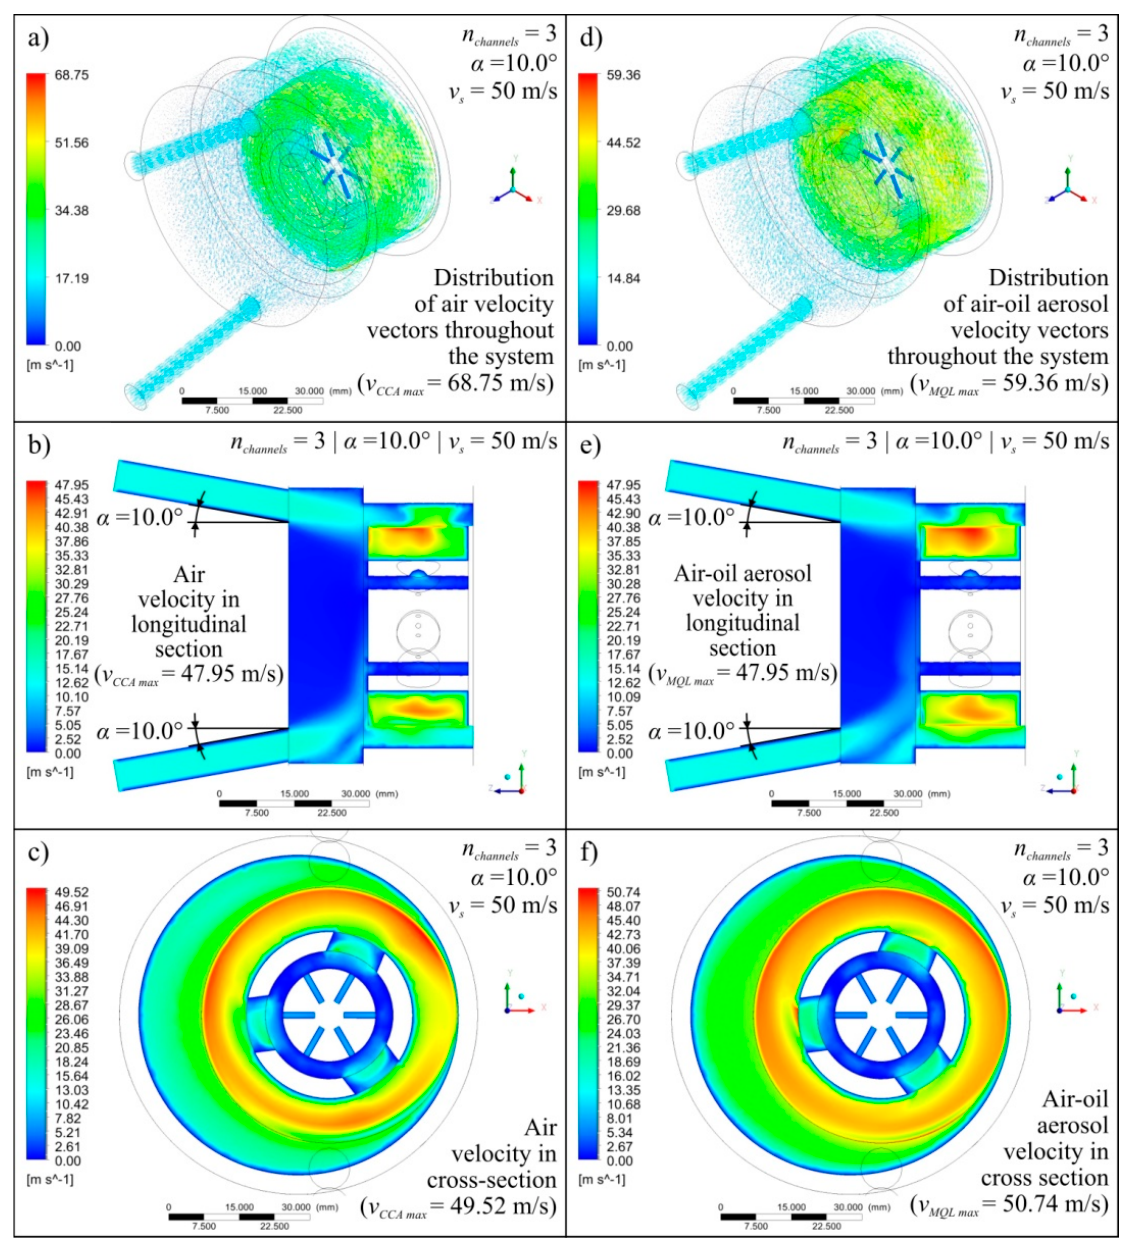
Figure 7. Exemplary simulation results for α = 10.0°, n channels = 3 and v s = 50 m/s presented as colour maps of air flow velocity ( a – c ) as well as oil mist flow velocity ( d – f ) in the entire system ( a , d ), in longitudinal section ( b , e ) and in cross-section ( c , f ).